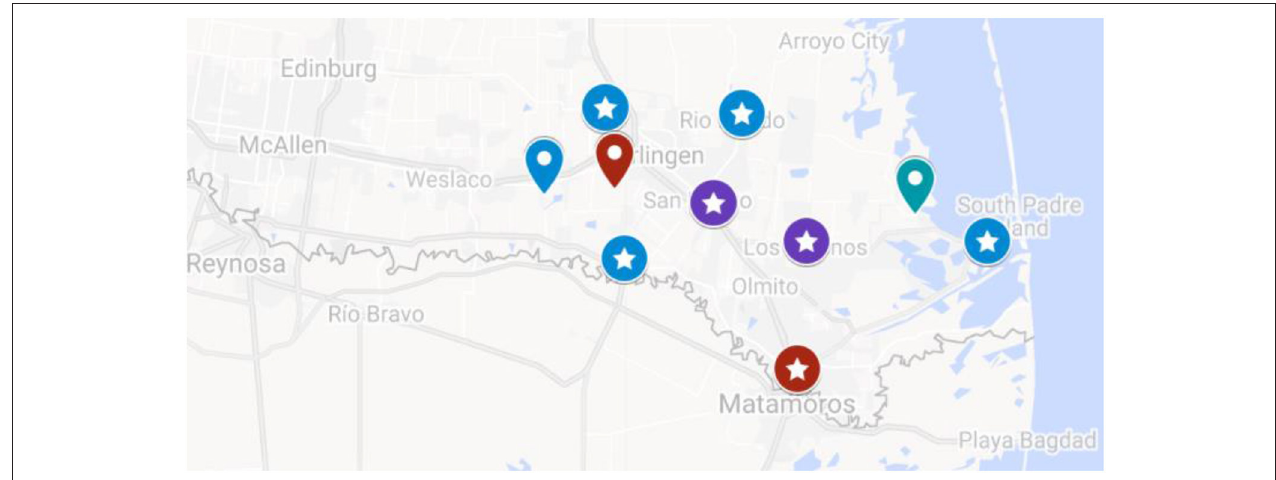
FIGURE 1 | Map of Participating Implementing Locations of the TSSC Program. Google map showing the location of the 12 municipalities in the TSSC study. Red labels are “Cities” with population sizes ranging from 75,000 to 200,000. Purple labels are “Towns” with a population size from 5,000 to 70,000. Blue labels are “Rural” areas with a population of < 5,000. Labels with stars indicate the municipalities with sufficient sample size ( n ≥ 35) that were included in the municipal-level